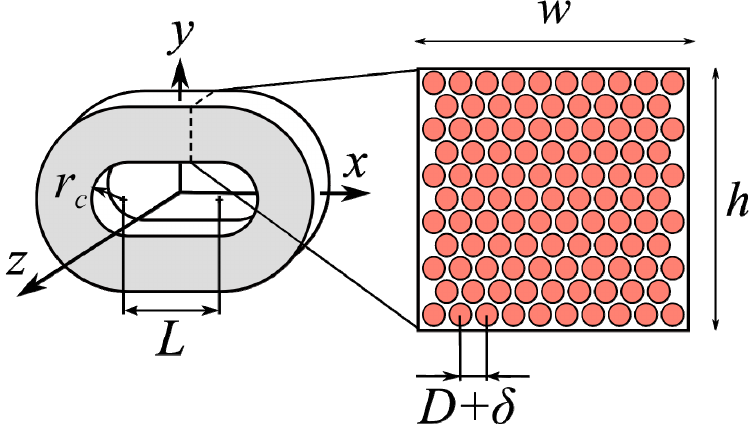
Figure 2. Racetrack coil with dimensions: r c —inner radius; L —active length; D wire diameter; δ —air-gap between wires; w , h —assumed width and height of coil walls, respectively.